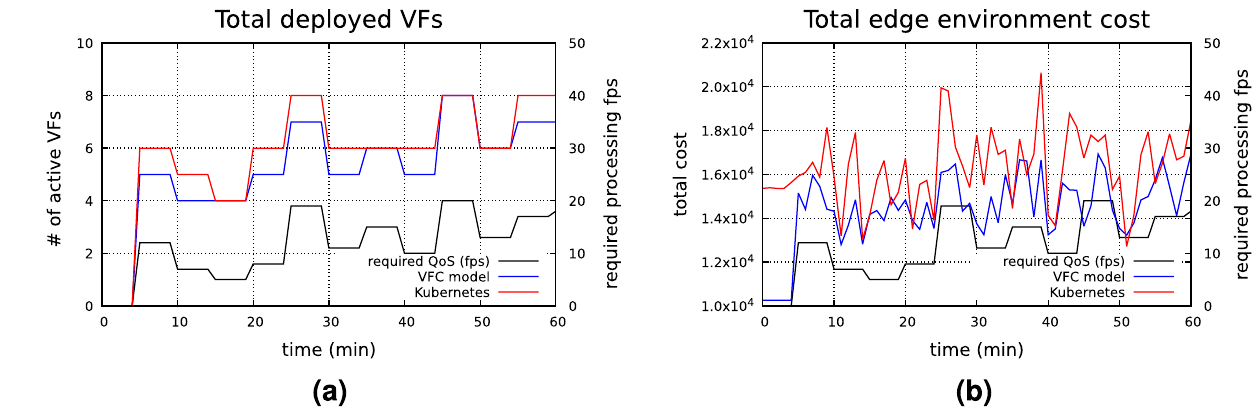
Figure 10. VFC model versus Kubernetes—deployed VFs ( a ) and total environment cost ( b